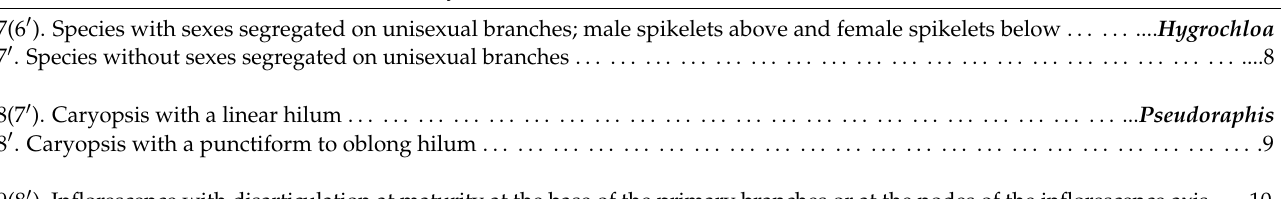
Key to Genera of the Subtribe